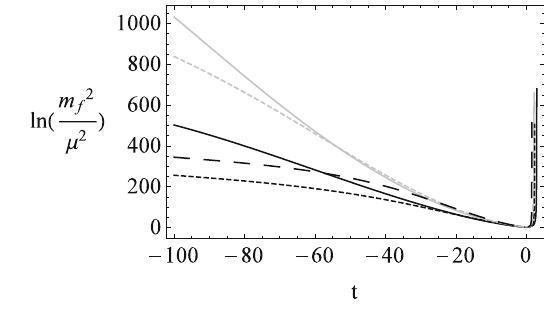
Fig. 12 The running of induced ln ( m 2 s /μ 2 ) and ln ( m 2 and right, respectively. These are plotted for f 2 ∗ = 10 − 8 , λ ∗ = 0 . 2 (black solid line), 0 . 25 (black short-dashed line), 0 . 3 (grey solid line), Fig. 13 The running of various dimensionless couplings. For this we took f 2 ∗ = 10 − 8 , λ ∗ = 0 . 1, ξ ∗ = 10 5 . We took ρ ∗ = 1 . 5 and (cid:2) = 10 − 16 , which gave y t ∗ = 0 . 46 and ω ∗ = 3 . 18 × 10 6 . Here μ is the running energy